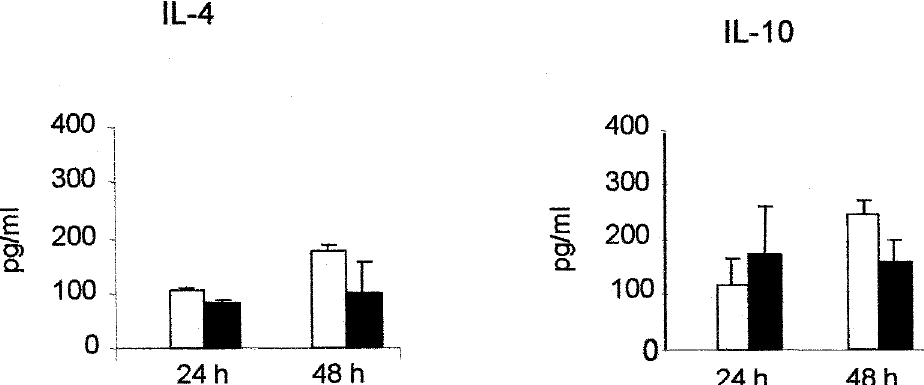
FIG. 4. Interference of metyrapone treatment on cytokine secretion induced by crotoxin (CTX). Animals were pre-treated with metyrapone (30mg/kg, intraperitoneally; every 12h, for 3 days) or equivalent volume of phosphate-buffered saline (PBS). Two hours after the last injections, CTX (5 m g/100 m l, subcutaneously) was administered. Spleen cells were collected 6h after toxin injection, and 5 ´ 10 6 cells/well were stimulated with concanavalin A (0.5ml of 10 m g/ml) during 24 or 48h at 37°C in an air chamber (5% CO 2 ). Cytokine levels in cell culture supernatants were determined by enzyme-linked immunosorbent assay. Results represent the mean of duplicate cell cultures ± SD from six animals treated with PBS and CTX ( h ) or with metyrapone and CTX ( j